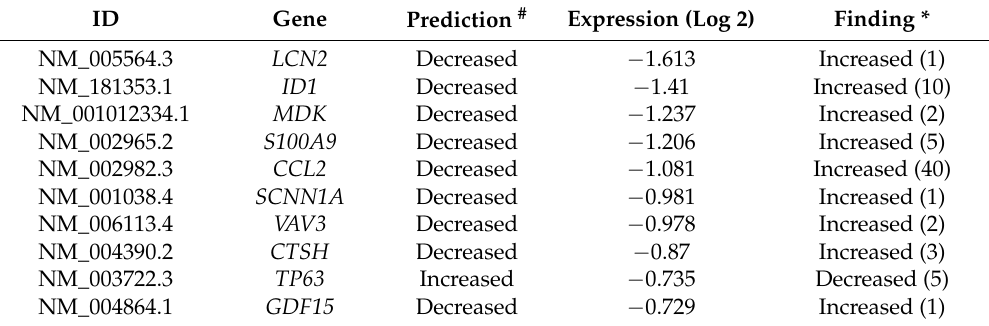
Decreased # Prediction of the effect of the target gene on OSCC migration after long-term Oro-A exposure. based on its expression direction. * The number of articles demonstrating a positive or negative relationship between the expression of the target gene and migration